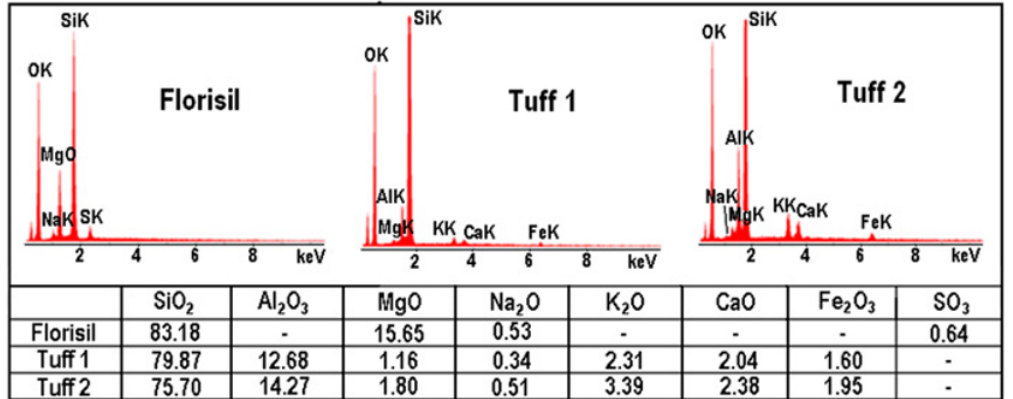
Figure 3. EDAX spectra and chemical composition of the studied